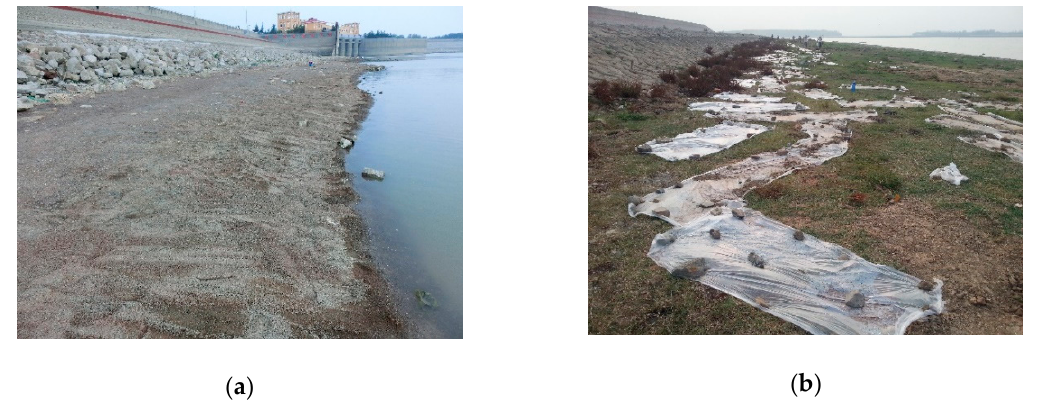
Figure 5. Treatment and prevention measures for cracks on the upstream slope of the dam. ( a ) Cover with stone flour; ( b ) Moisture retention with plastic sheets.